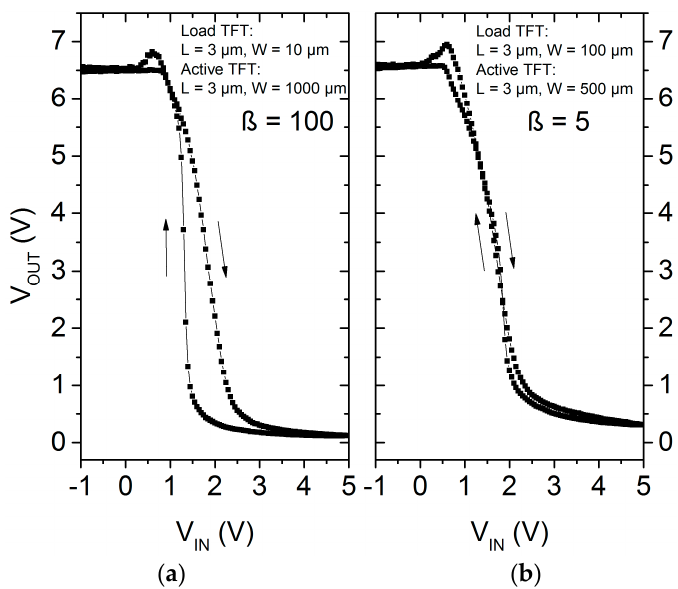
Figure 10. Voltage transfer characteristics of a ZnO nanoparticle inverter with geometry ratio ( a ) equal to 100 and ( b ) equal to 5 and with V DD = 7.5 V.